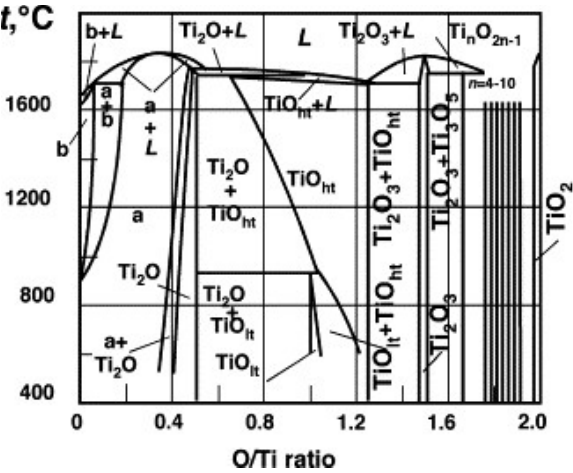
Figure 1. Phase diagram of the Ti-O system. The region Ti 2 O 3 -TiO 2 contains Ti 3 O 5 , Ti 2 O 3 and seven discrete phases of the homologous series Ti n O 2n−1 (Magneli phase) and TiO 2 . Reproduced from [35]; Copyright 2003, Elsevier.